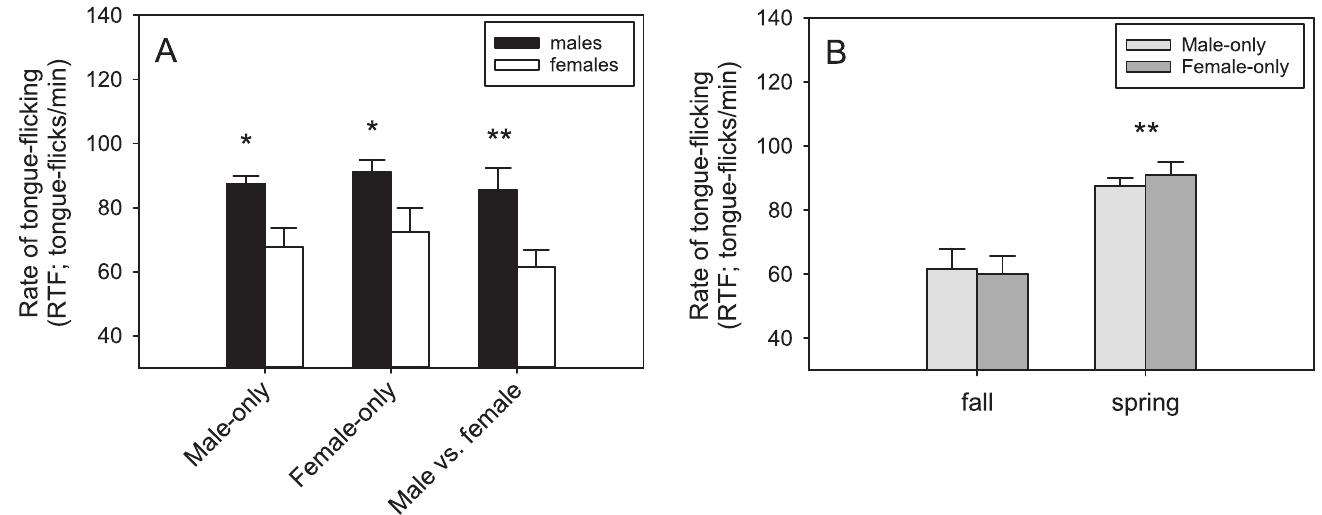
Fig 5. Rates of tongue-flicking by tegus in the Y-maze. A) Rates of tongue-flicking (RTF) in the initial phase of trials were higher in male tegus compared to female tegus. However, RTF was not different based on trial type within each sex. B) Males also have higher RTFs in spring than in fall during the initial phase. Bars represent means (+SEM). � P < 0.05, �� P <